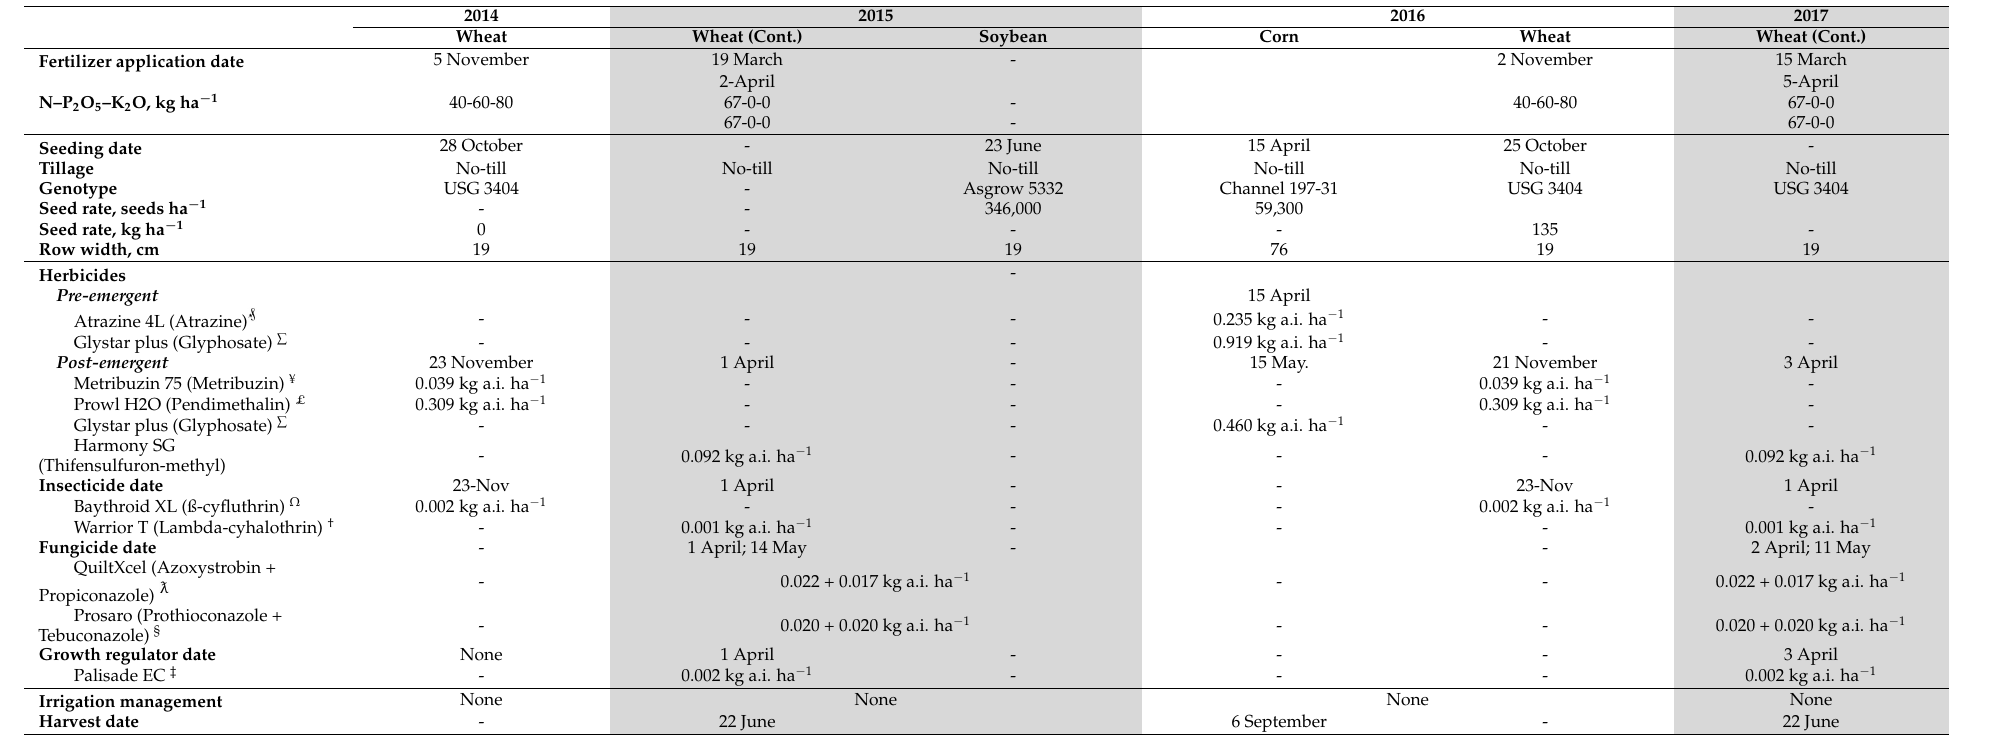
Table 3. Detail of the management practices performed in NK1 in the period 2014–2017 at Lanexa, New Kent, VA, USA